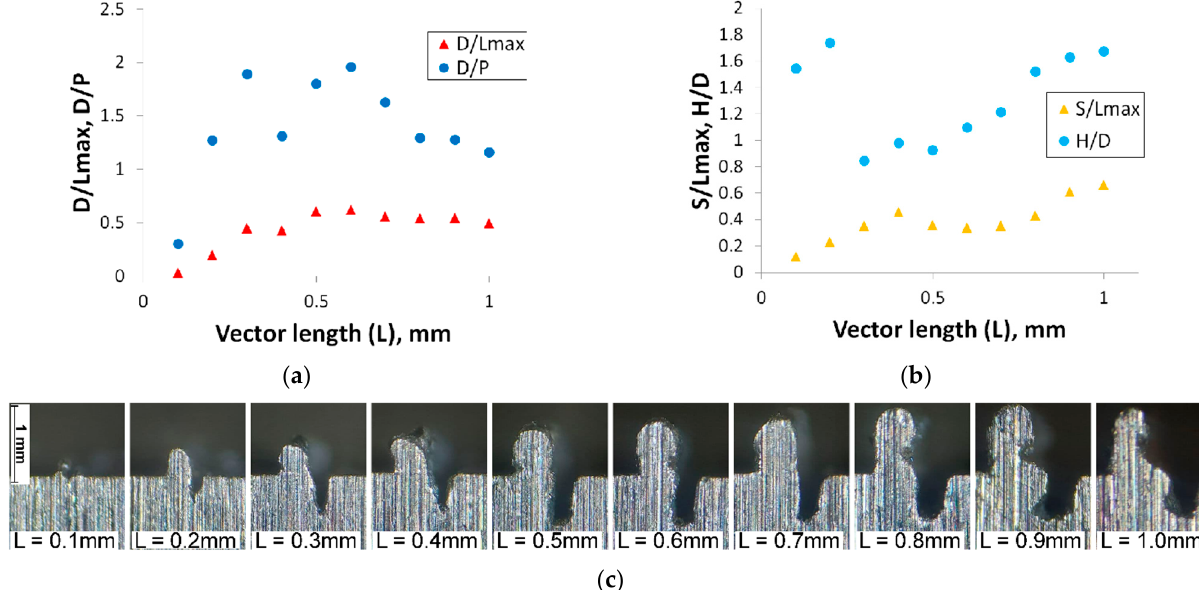
Figure 6. Graphs of the dependences of the investigated parameters ( a ) D, P and ( b ) S, H on the length of vectors ( L ), as well as ( c ) the transverse sections of the grooves obtained at different values of L (0.1–1 mm).